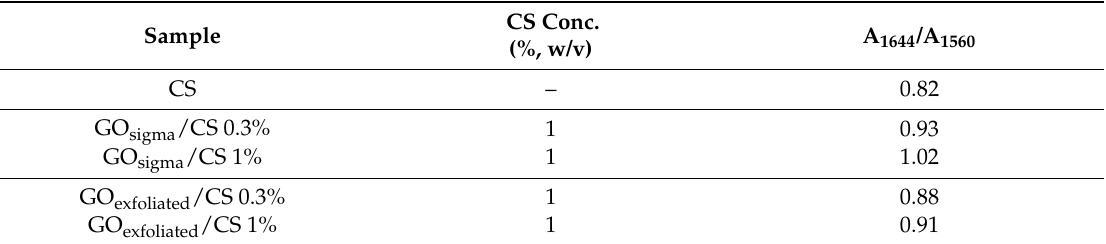
Figure 5. FTIR spectra of GO sigma , GO exfoliated , chitosan and of the GO-functionalized chitosan obtained with GO sigma , and a GO/CS weight ratio of 0.3%. Table 3. Intensity ratio of peaks at 1644 cm − 1 and 1560 cm − 1 (A 1644 /A 1560 ) for the GO/CS samples.